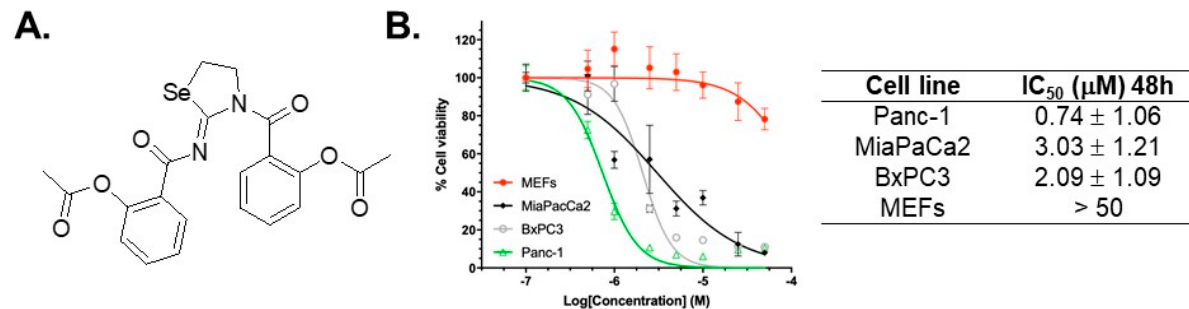
Figure 1. AS-10 selectively inhibited PDAC cell growth. ( A ) Structure of AS-10. ( B ) Cell number/viability MTT assay and IC 50 chart. Panc-1, MiaPaCa2, BxPC3, and MEF cells were treated with AS-10 (concentration range 0–50 µM) for 48 h. Curves by non-linear regression using variable slope equation in GraphPad prism software show the cell number relative to the respective DMSO control. Data represented as mean ± SD. IC 50 data represented as mean ± SD of three independent experiments.